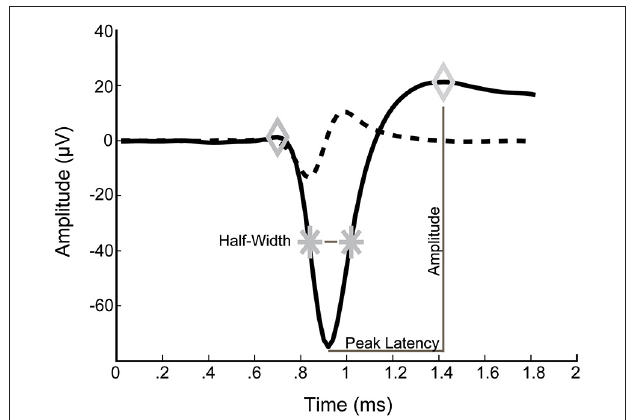
FIGURE 1 | Typical example of an averaged spike waveform from a 14 DIV culture . Left and right diamonds correspond to detected maxima. Stars indicate spike half-amplitude. Dashed line is the first derivative of the average waveform. estimated by visual inspection. The spike datasets consisted of vectors for all